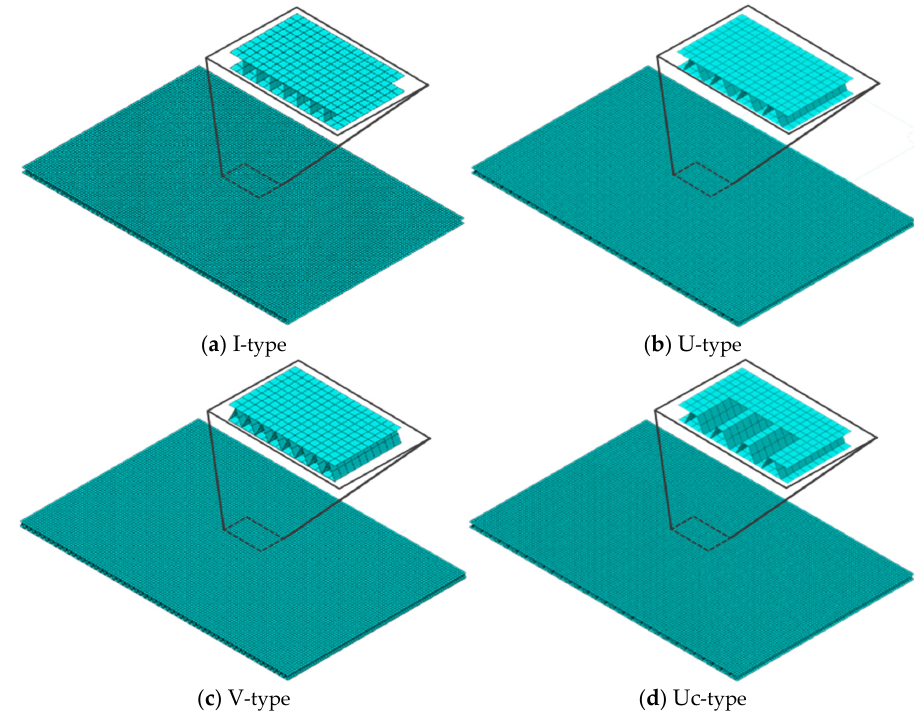
Figure 6. Finite element models of the four typical metal sandwich structures.